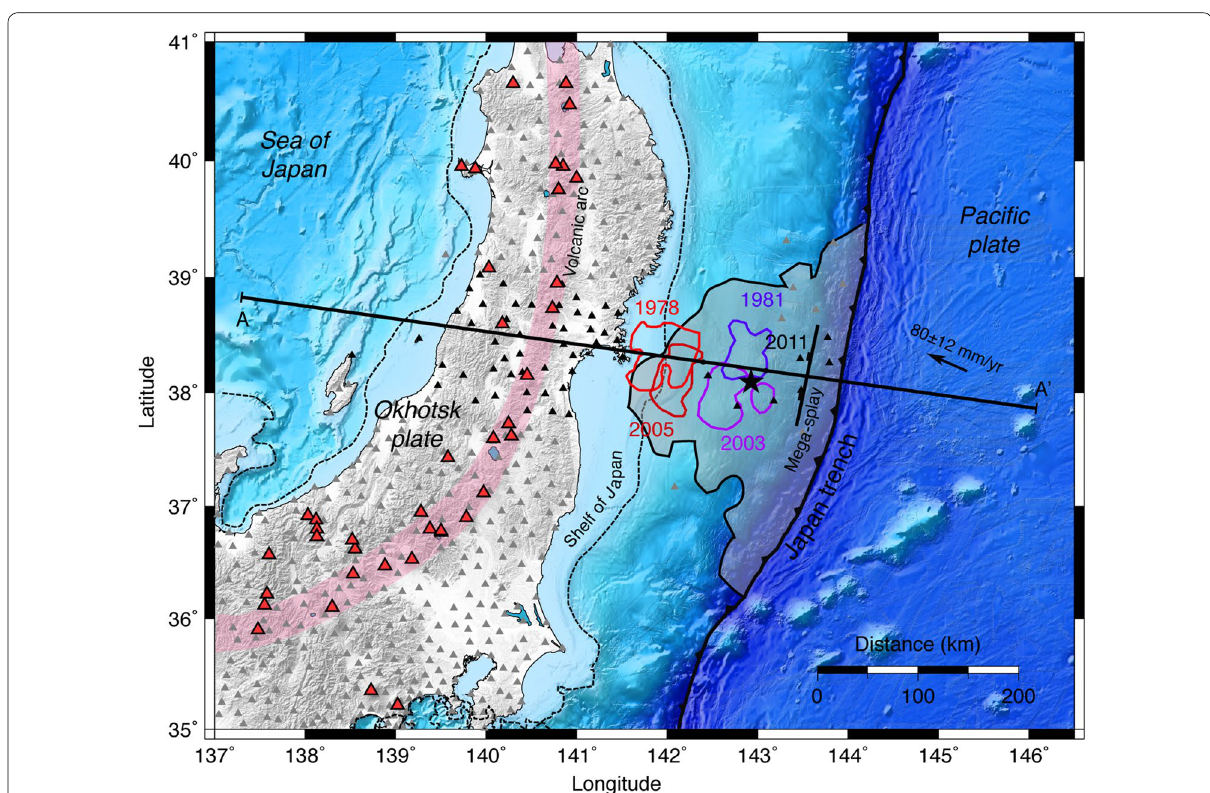
Fig. 1 Tectonic setting in northeast Japan and seismic cycle at the Miyagi segment. The rupture area of large earthquakes in the last century, including the 1978 and 2005 Mj ∼ 7 earthquakes, the 1981 Mw 7.1 and 2003 Mw 6.9 earthquakes (Nakata et al. 2016), and the 2011 Mw 9.1 = = = Tohoku earthquake (Bletery et al. 2014), are shown in colored contours. The continental shelf (dashed profile) provides an indication on the extent of the Japanese island arc (volcanos as red triangles). The triangles represent GEONET GPS stations on land (Sagiya et al. 2000; Ozawa et al. 2011), and seafloor geodesy monuments offshore (Watanabe et al. 2014; Tomita et al. 2015). Only the geodetic data within 50 km of the two-dimensional cross-section A–A’ are considered (black